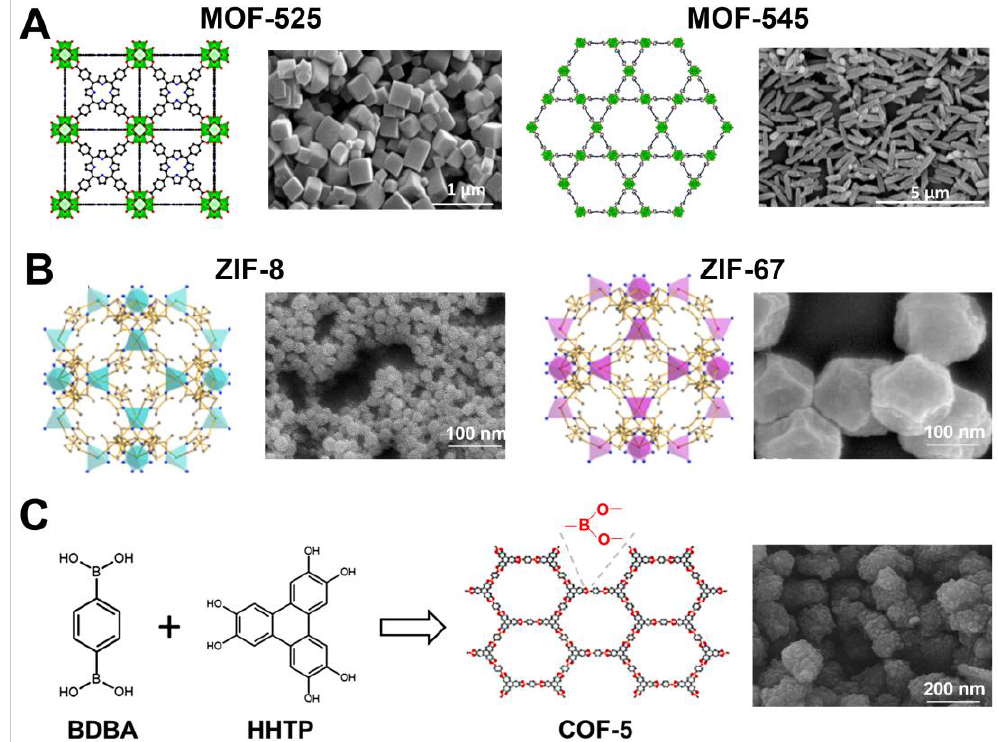
Figure 10. ( A ) Schematic illustration of structures and SEM images of MOF-525 and MOF-545. The green polyhedrons are Zr atoms, while the red, blue, and black spheres are oxygen, nitrogen, and carbon atoms [102]. Reproduced with permission from ref. [102]. Copyright 2021, Elsevier Inc. ( B ) Schematic representation of crystal structures of ZIF-8 and ZIF-67 (blue and purple tetrahedra represent tetrahedrally coordinated zinc and cobalt, respectively) [107]. Reproduced with permission from ref. [107]. Copyright 2020, Elsevier Inc. ( C ) Schematic illustration of synthesis of COF-5 and its SEM image [111]. Reproduced with permission from ref. [111]. Copyright 2018, Elsevier B.V.